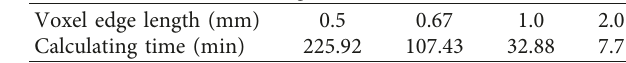
Table 3: Calculating time of different models. Voxel edge length (mm)